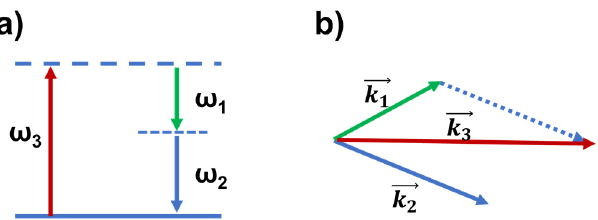
Figure 1. ( a ) Diagram of a SPDC process: ( b ) Representation of the energy ( a ) and momentum ( b ) conservation for a SPDC process where photon γ 3 at energy ω 3 and momentum k 3 splits into two photons γ 1 and γ 2 at energies ω 1 , ω 2 and momentum k 1 , k 2 .